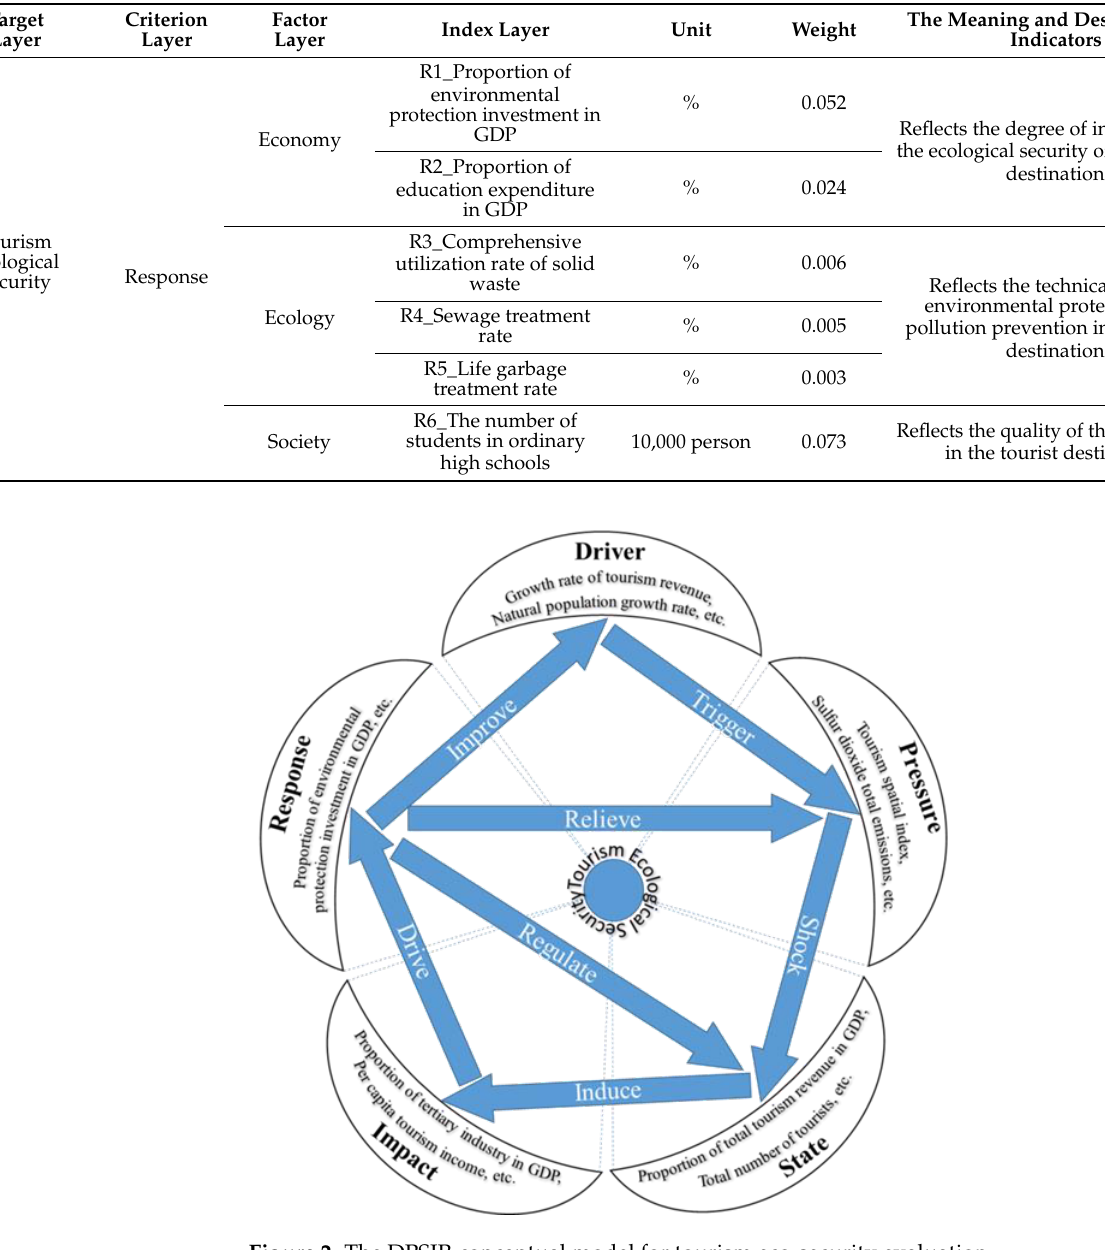
Table 1. Comprehensive evaluation index system of tourism eco-security in the Yellow River basin.